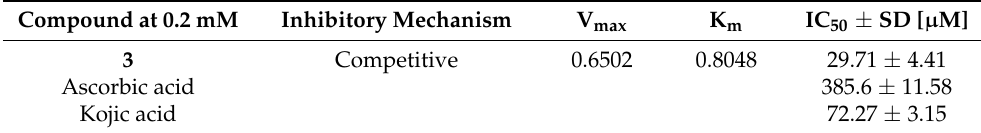
Table 1. Tyrosinase inhibitory activity of compound 3 and its mechanism of action. Compound at 0.2